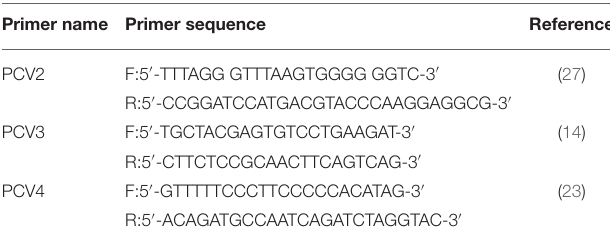
TABLE 1 | Primer sequences used porcine circovirus diseases.